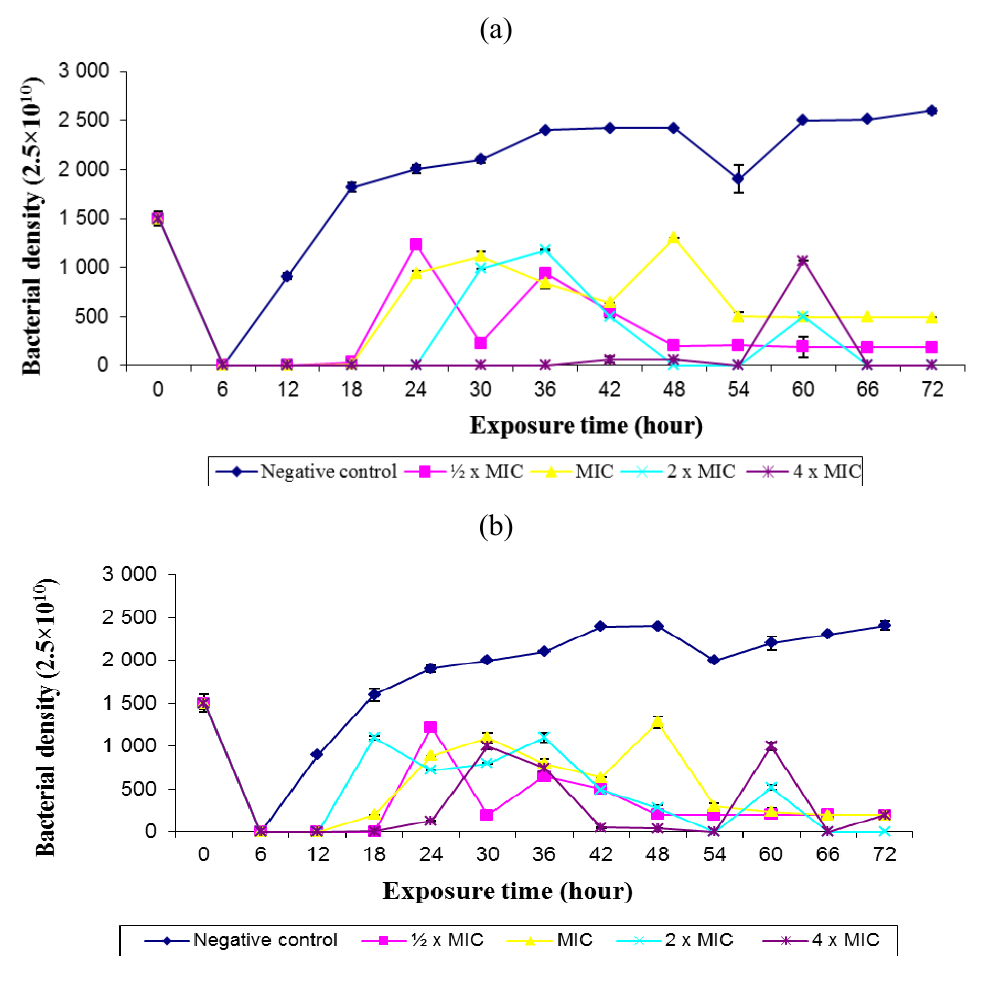
Figure 3. Profile of rate of kill of H. pylori strain ( a ) PE430C and ( b ) PE369C by ethyl acetate extract of Bridelia micrantha stem bark compared to untreated strain (negative control).